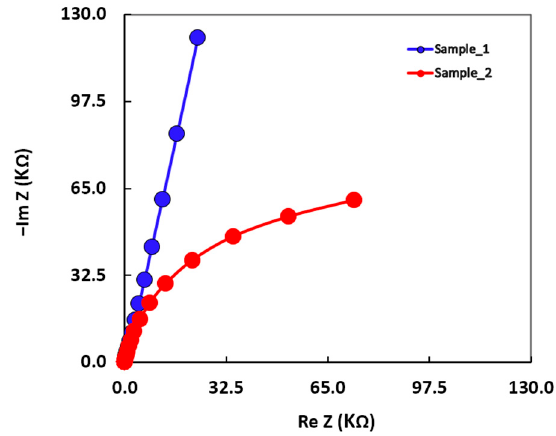
Figure 6. Nyquist diagrams for Sample 1 and Sample 2.